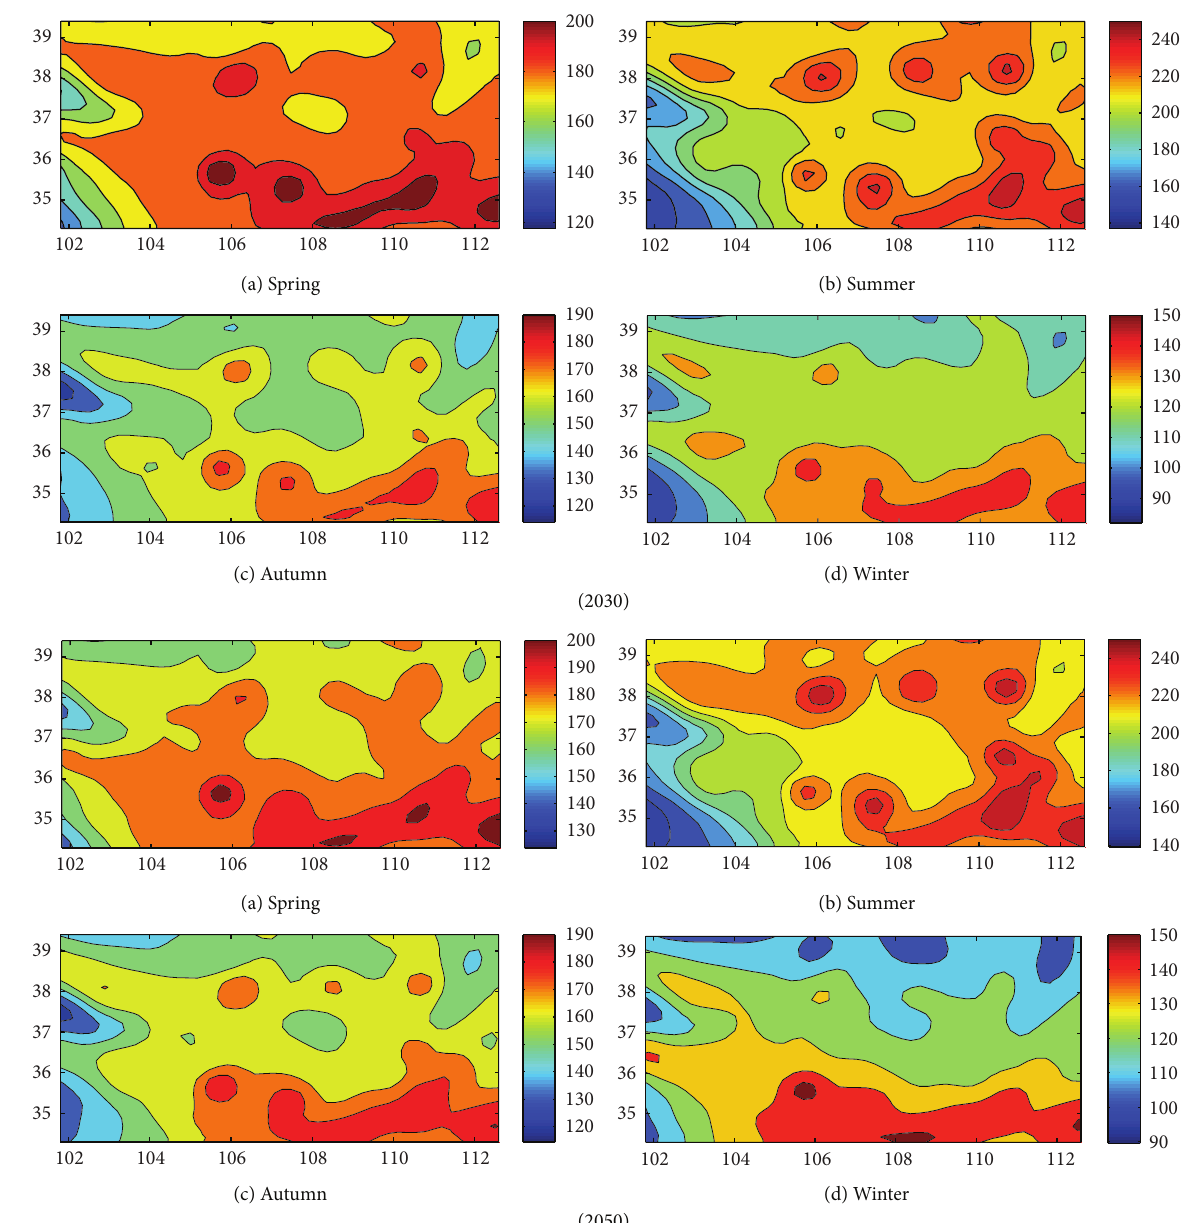
Figure 4: Downward long wave radiation in 2030 and